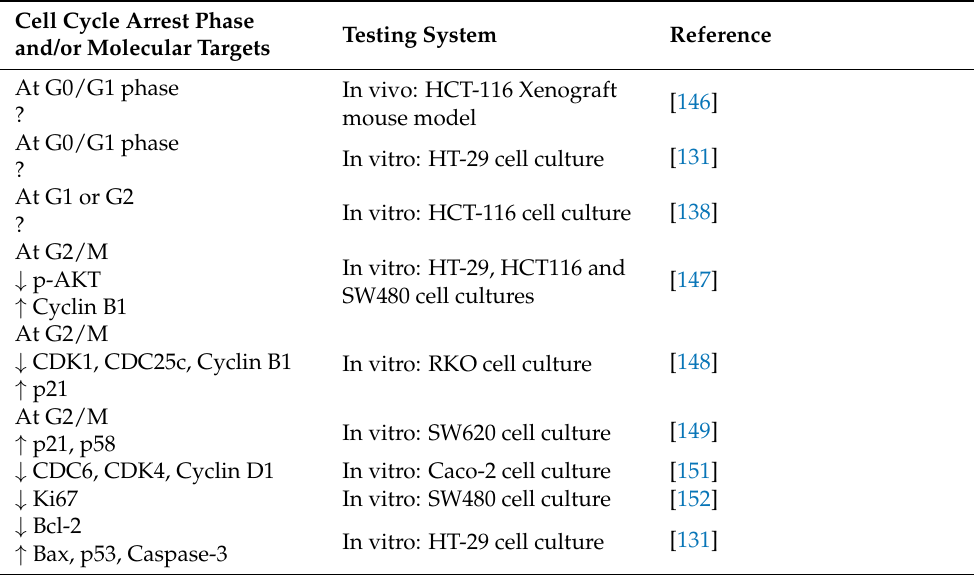
Table 4. Reported targets of quercetin active in cell cycle arrest of CRC models alongside their in vivo/in vitro testing system. “ ↑ ” and “ ↓ ” arrows are indicating the up- and downregulation, respectively, while “?” denotes the lack of specific targets in the respective